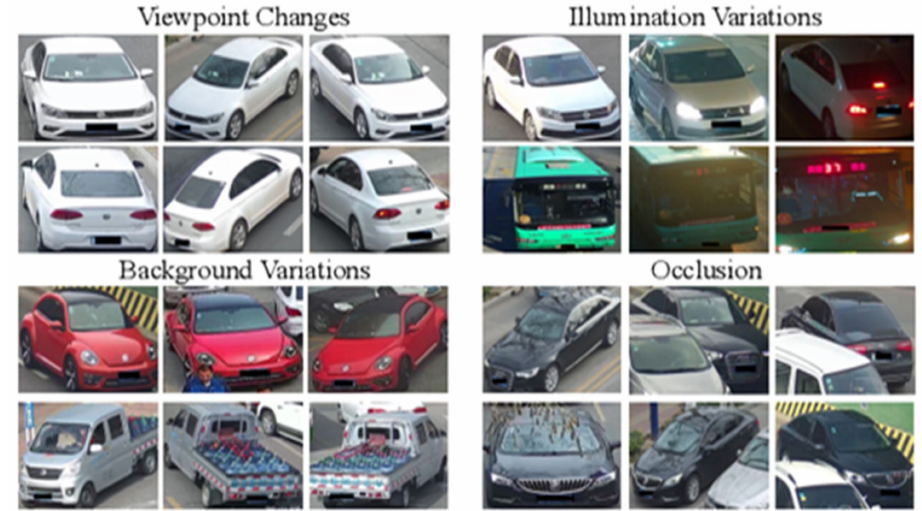
Figure 25. Depicts the sample images of VERI-Wild